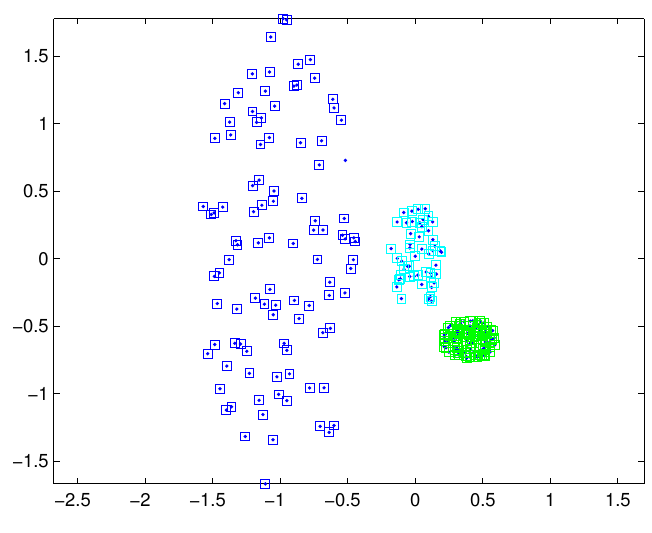
Figure 5. Partition by SNNDP for a certain similarity threshold.